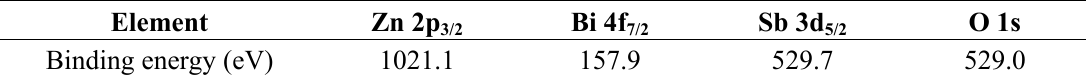
Table 2. Binding energies for key elements of ZnBiSbO